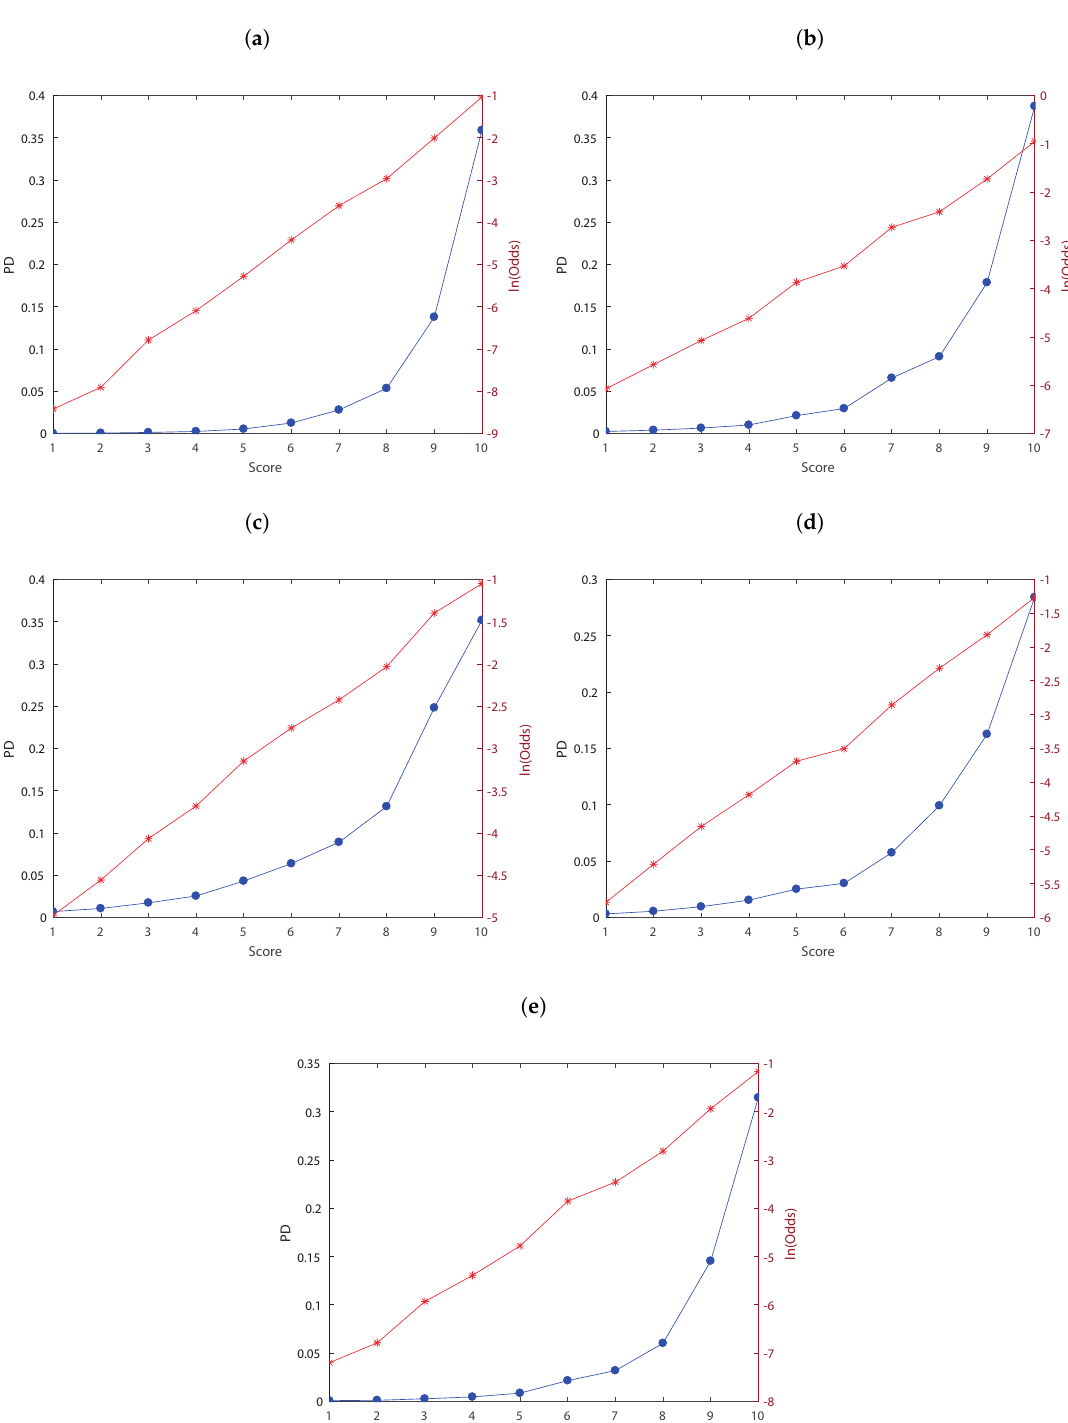
Figure A2. Master scale for the sample. We illustrate 2014H1 (Panel ( a )), 2014H2 (Panel ( b )), 2015H1 (Panel ( c )), 2015H2 (Panel ( d )), 2016H1 (Panel ( e